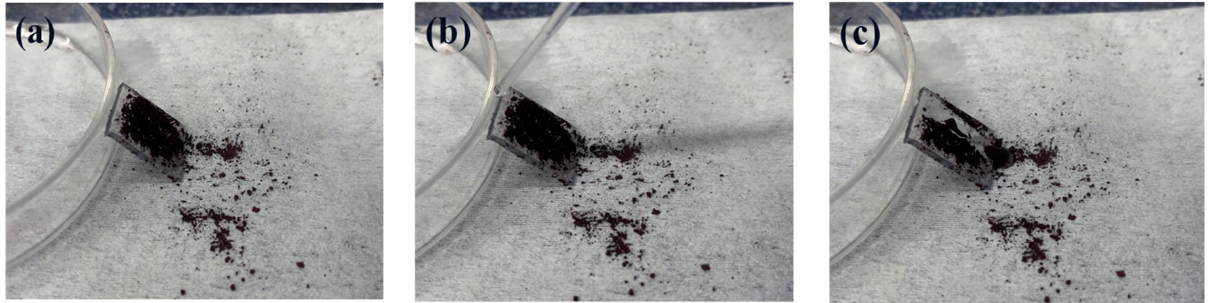
Figure 6. ( a – c ) Self-cleaning test for the PFTS-modi fi ed sample.